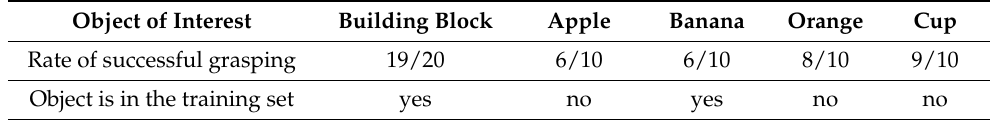
Figure 17. Object grasping point provided by SAC for different objects of interest (red point inside the bounding box in the upper environment image; white point in the lower depth image); the “arrow” sign is used to indicate the object of interest. Table 3. Rate of successful grasping for different objects.